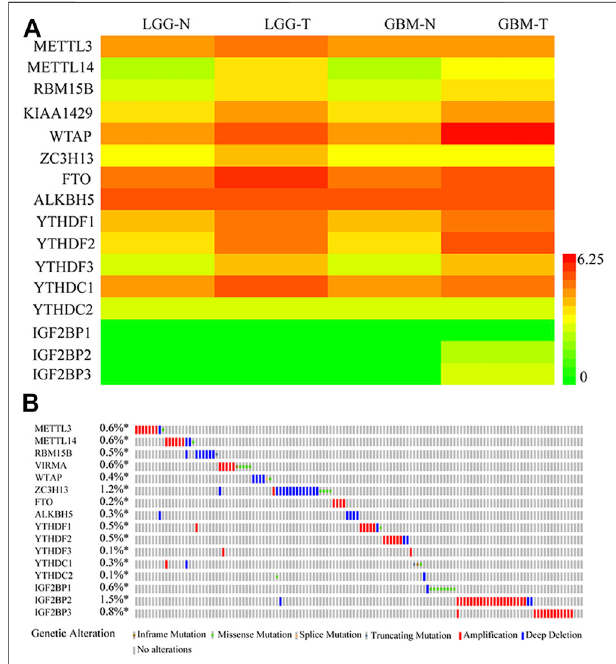
FIGURE1| Expressionand genetic alterations inthem 6 A-related genes ingliomas. (A) Expressionpro fi lesofthem 6 A-relatedgenesintheTCGA-LGG and TCGA-GBM datasets. (B) Genetic alteration pro fi les of the m 6 A-related genes. The data were from the cBioportal for Cancer Genomics. N, Normal; T,